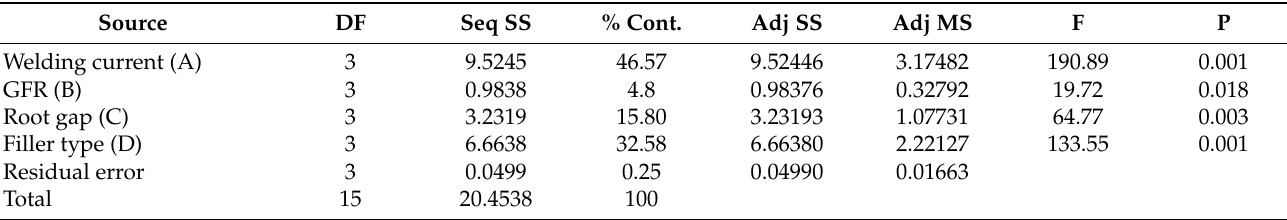
Table 18. Analysis of variance (ANOVA) for Flexural